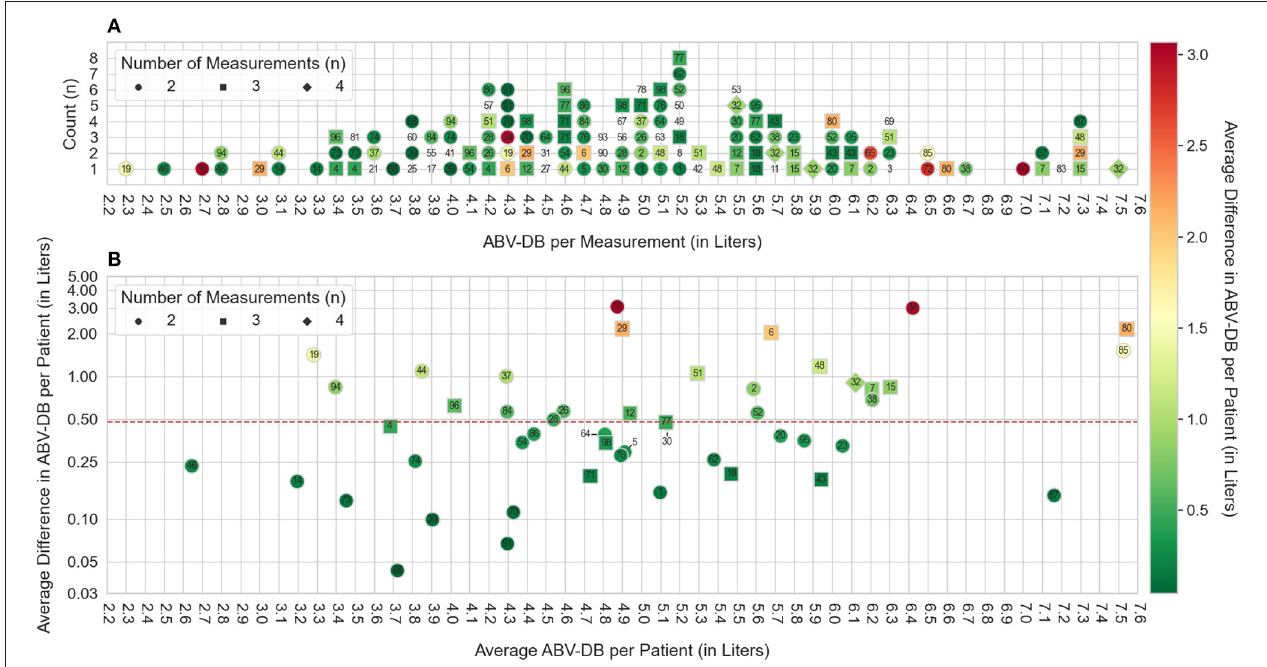
FIGURE 4 | ABV-DB distribution and standard deviation (based on 75 patients, 145 sessions). (A) Stacked dot-plot assessing ABV-DBs between 2.2 and 7.3 liters (70 Patients, 116 Sessions fall within this cut-off). Numeric patient identifiers are annotated for each ABV-DB estimate. The vertical axis shows the count of estimates which fall within a given 0.1L interval of ABV-DB. Coloring of the annotation represents the average difference in ABV-DB observed in the respective patient, as specified in the color bar to the right of the figure: Green denotes high agreement between estimates, red denotes poor agreement. Patients without a colored contour marker did not have a second ABV-DB estimate available for comparison and therefore their average difference of ABV-DBs could not be calculated. (B) The horizontal axis here denotes the average ABV-DB for the corresponding patient. Coloring of annotations is analogous to (A) The vertical axis is on a logarithmic scale and denotes the average difference between ABV-BD estimates observed within the patient and is analogous to the coloring of the annotation. Patient 5, 30, and 64 were annotated with an offset to improve readability. The median average intra-patient difference in ABV-DB for all patients is denoted by a red dashed